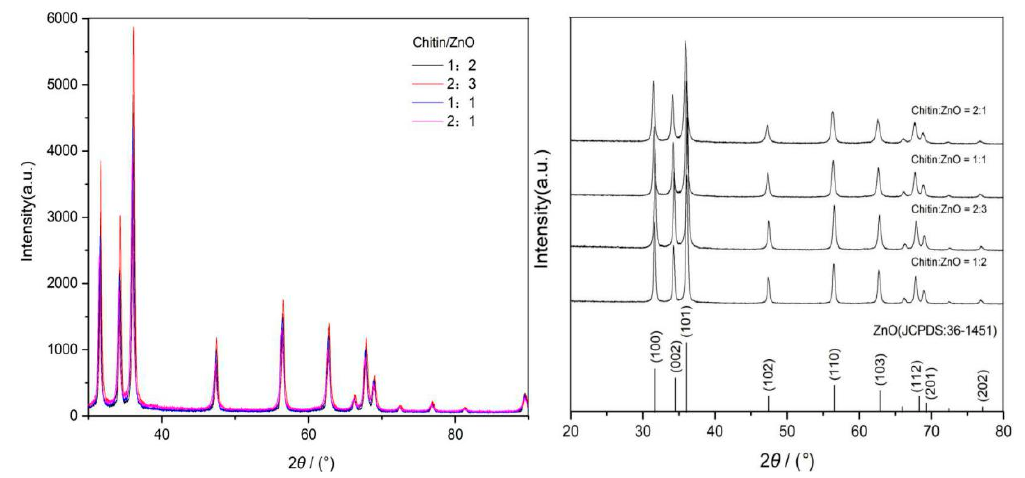
Figure 12. The XRD in the 2-theta region for the Chitin/ZnO.